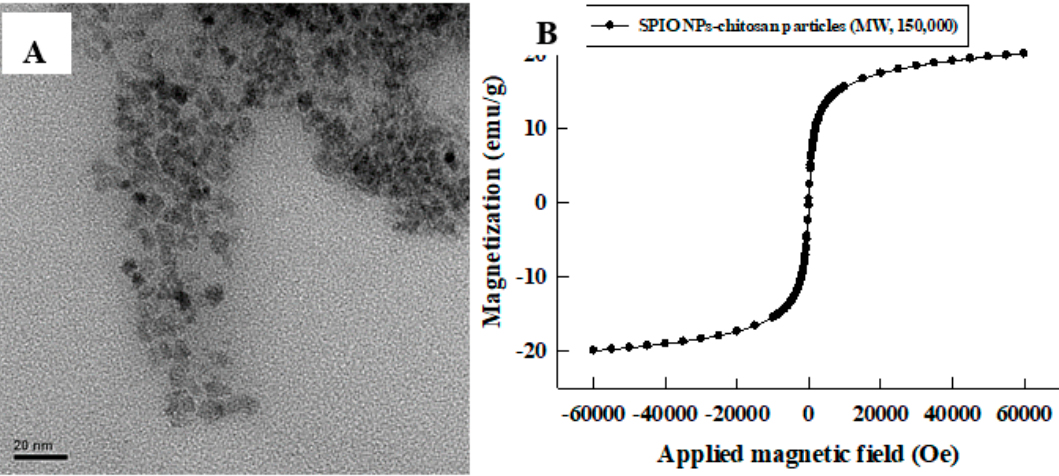
Figure 6. The ( A ) TEM image (scale bar is 20 nm) and ( B ) SQUID data of the synthesized SPIO NPs–chitosan particles.